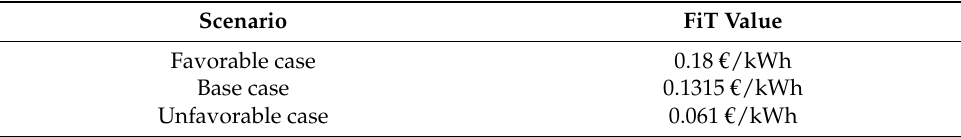
Table 2. FiT scenarios. Source: self-elaboration based on [40–42].